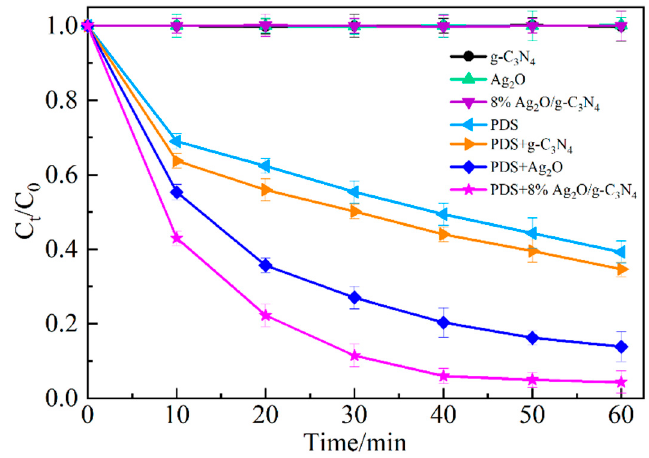
Figure 5. Degradation of MO under different activation conditions.